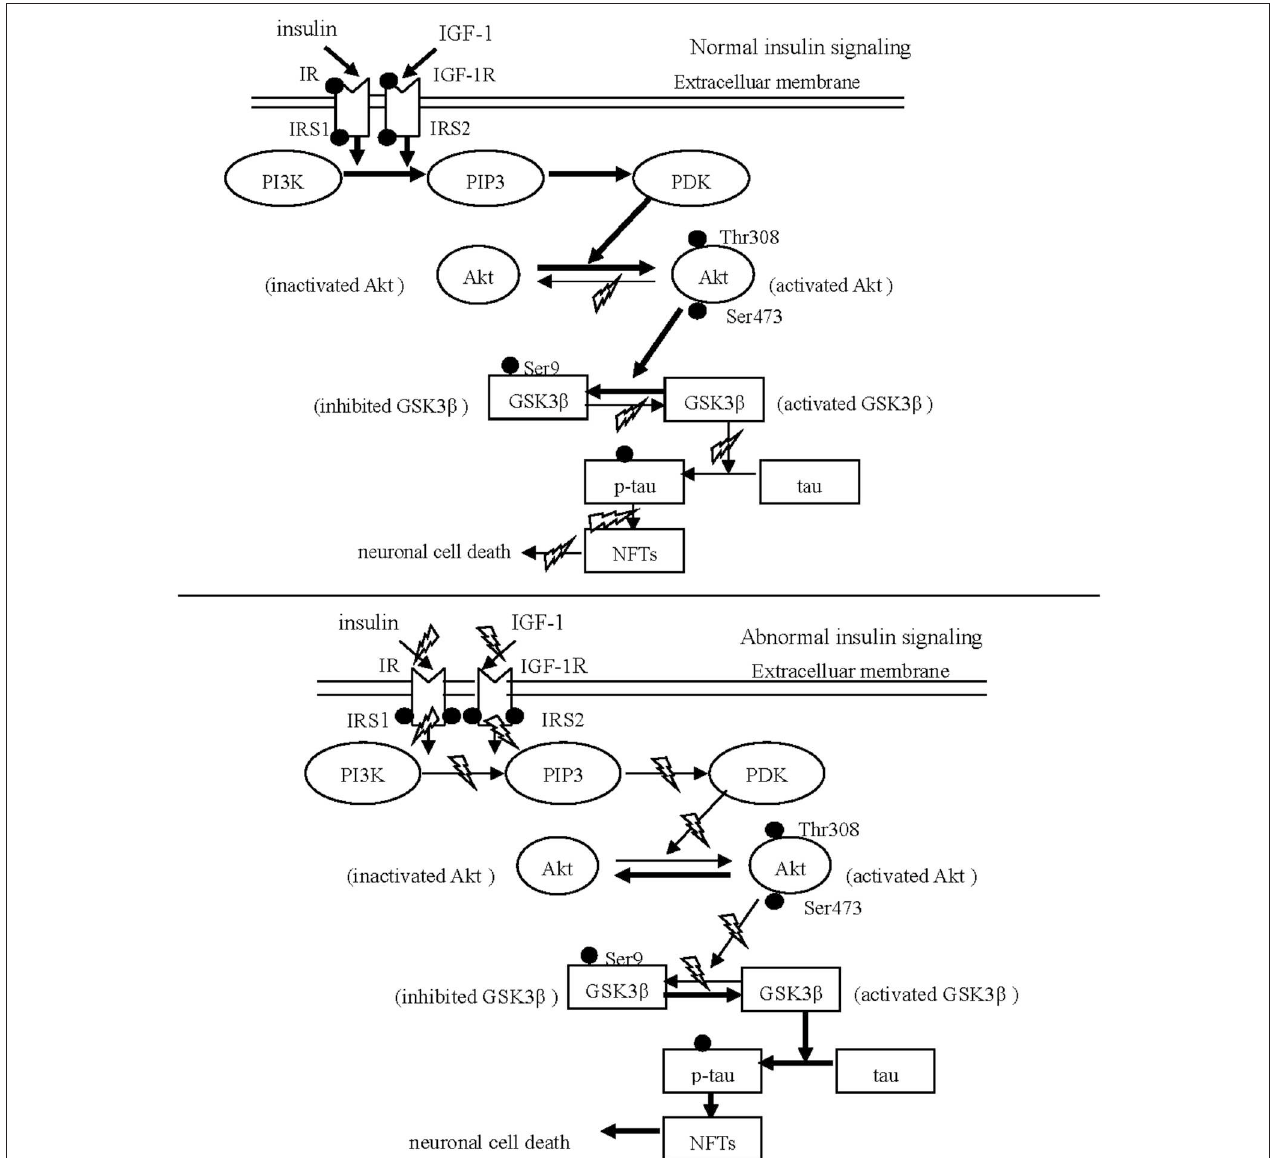
FIGURE 1 | Schematic drawing of insulin/IGF-1/PI3K/Akt/GSK3 β /tau signaling. The normal insulin signaling pathway Insulin and IGF-1 are internalized neurons via respectively binding to IR and IGF-1 R. After phosphorylation of IR and IGF-1 R, IRS is phosphorylated to initiate the down-stream substrate, PI3K. Subsequently, Akt is activated in response to PI3K signaling via phosphorylated by PDK. The activated Akt phosphorylates GSK31 β at Ser 9, leading to GSK31 β inhibited. The abnormal insulin signaling pathway Insulin and IGF-1 can not trigger the down-stream signaling in PD and AD, resulting from the reduced phosphorylation of IR and IGF-1 R